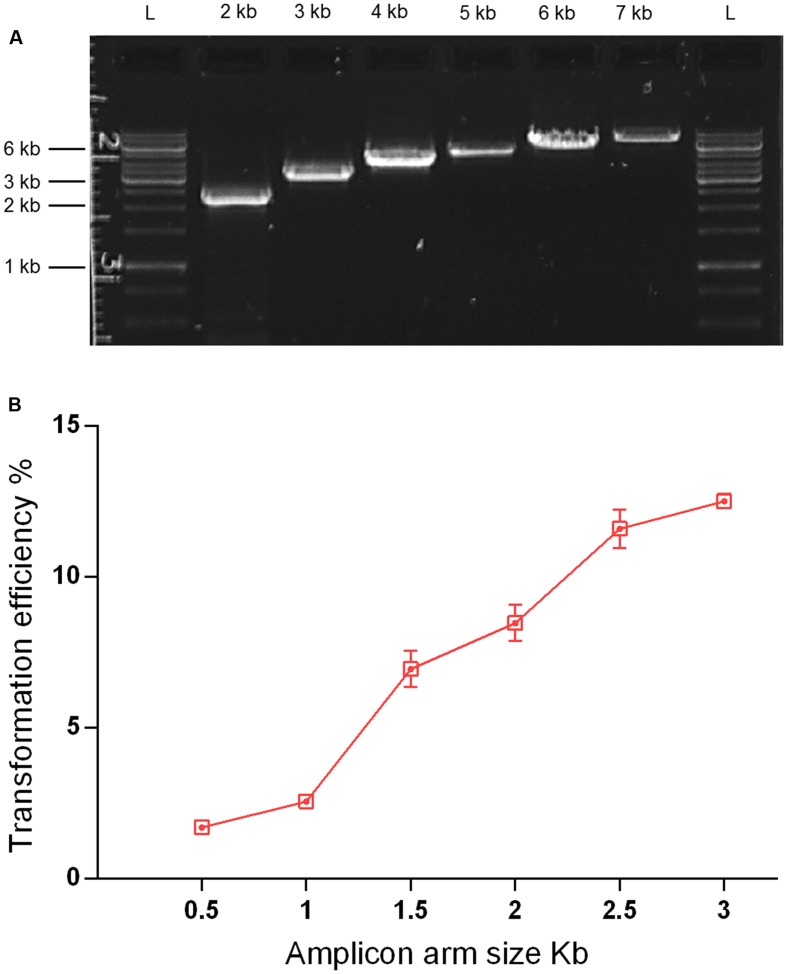
Effect of amplicon arm size on transformation. (A) Gel analysis of six amplicons of different sizes derived from the same genomic template (MI009). L, DNA ladder Gene Ruler 1kb (GenScript). (B) Transformation as a function of amplicon arm sizes. S. mitis type strain pre-culture at OD600 0.5 was diluted 1:100 in C+YY B and grown until OD600 0.04 at 37°C in 5% CO2. Following, 200 μL aliquots were exposed to 300 nM of CSP, 150 ng mL-1 donor DNA amplicon (aRJ20, aRJ22, aRJ23, aRJ24, aRJ25, and aRJ26) and further incubated in closed tubes for 4 h at 37°C in air atmosphere. The % of CFU containing ErmR transformants was determined by plating on blood plates with and without Erm. The results are averages from three replicates and representative of three independent experiments. Error bars represent standard error of the mean.